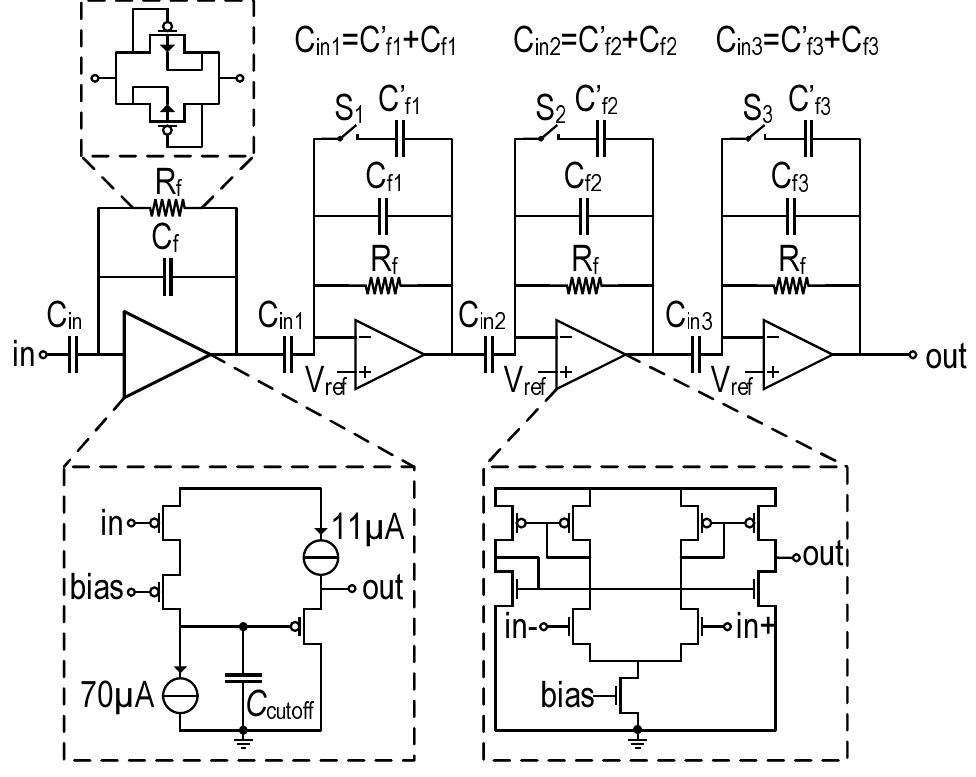
Figure 5. Schematic of the in-pixel adjustable gain